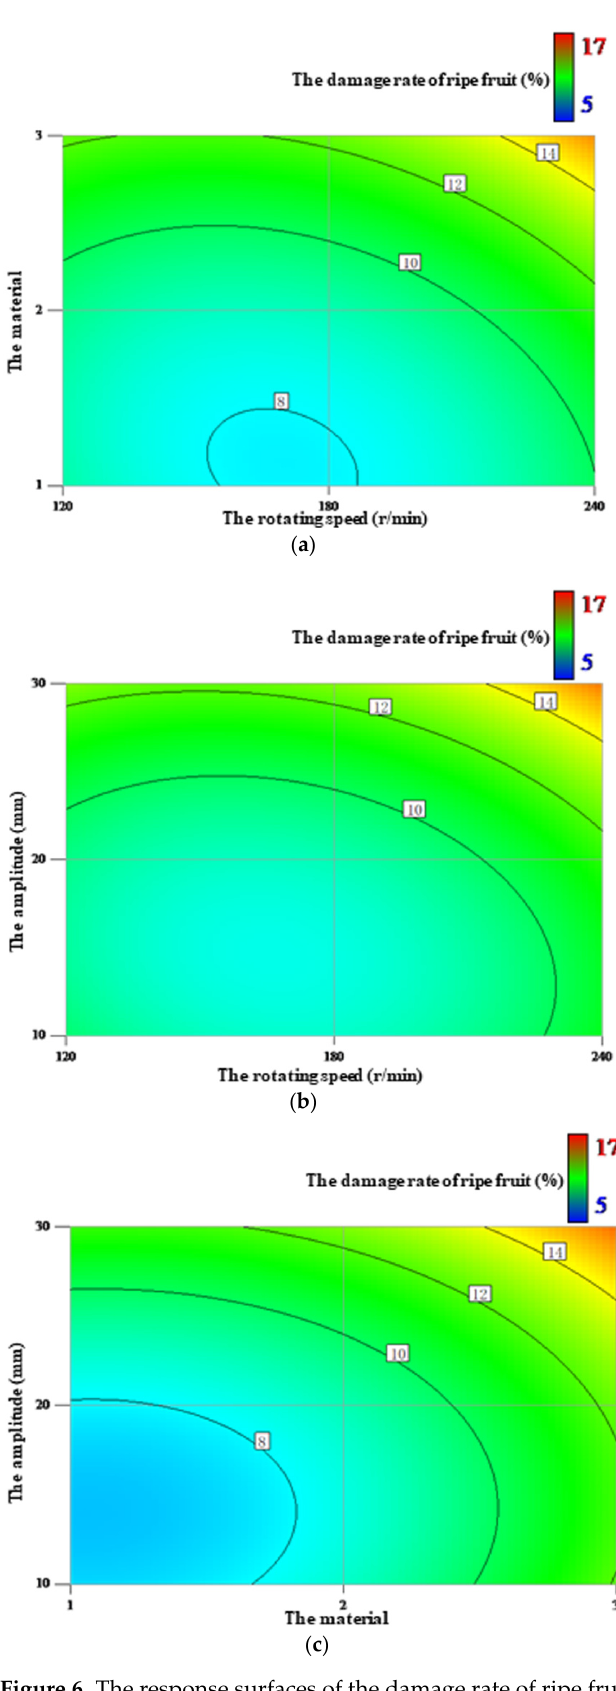
Figure 6. The response surfaces of the damage rate of ripe fruit affected by the rotating speed and material ( a ), the rotating speed and amplitude ( b ), and the material and amplitude ( c ). With the goal of maximizing the harvesting rate of ripe fruit while minimizing the harvesting rate of unripe fruit and damage rate of ripe fruit, these experiments showed that the optimal parameters were a rotating speed of 180 r/min, using the silica gel, an amplitude of 15 mm.